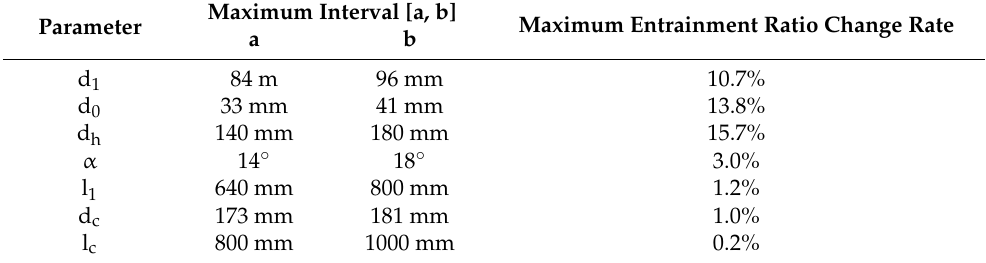
Table 4. Maximum entrainment ratio interval and maximum entrainment ratio change rate in the interval of ejector structure.